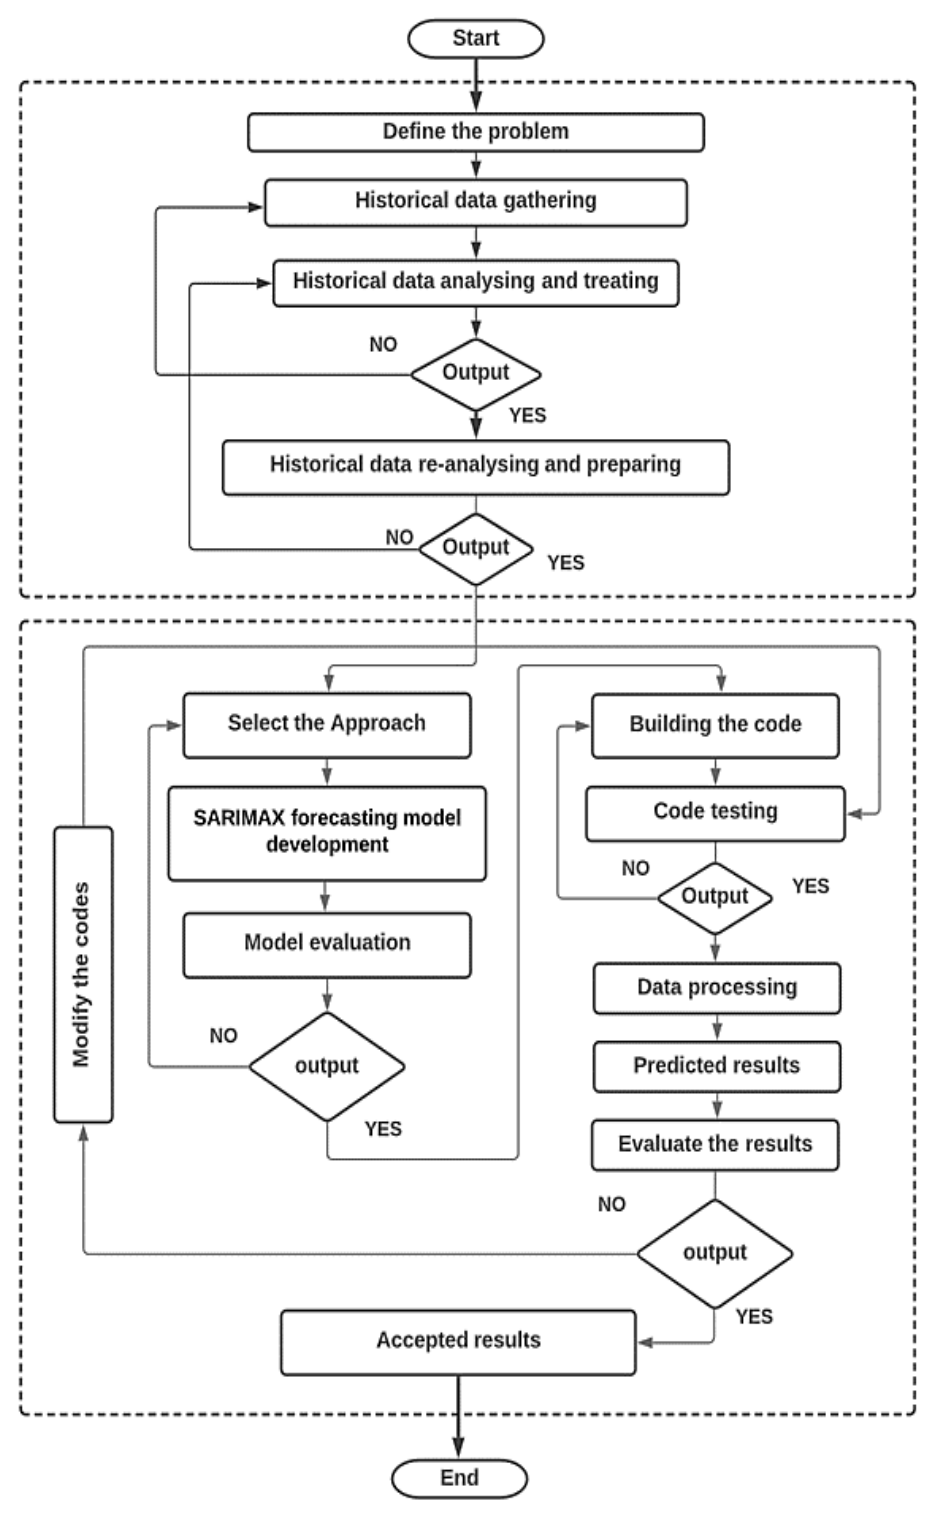
Figure 5. Flowchart of the proposed SARIMAX forecasting model.